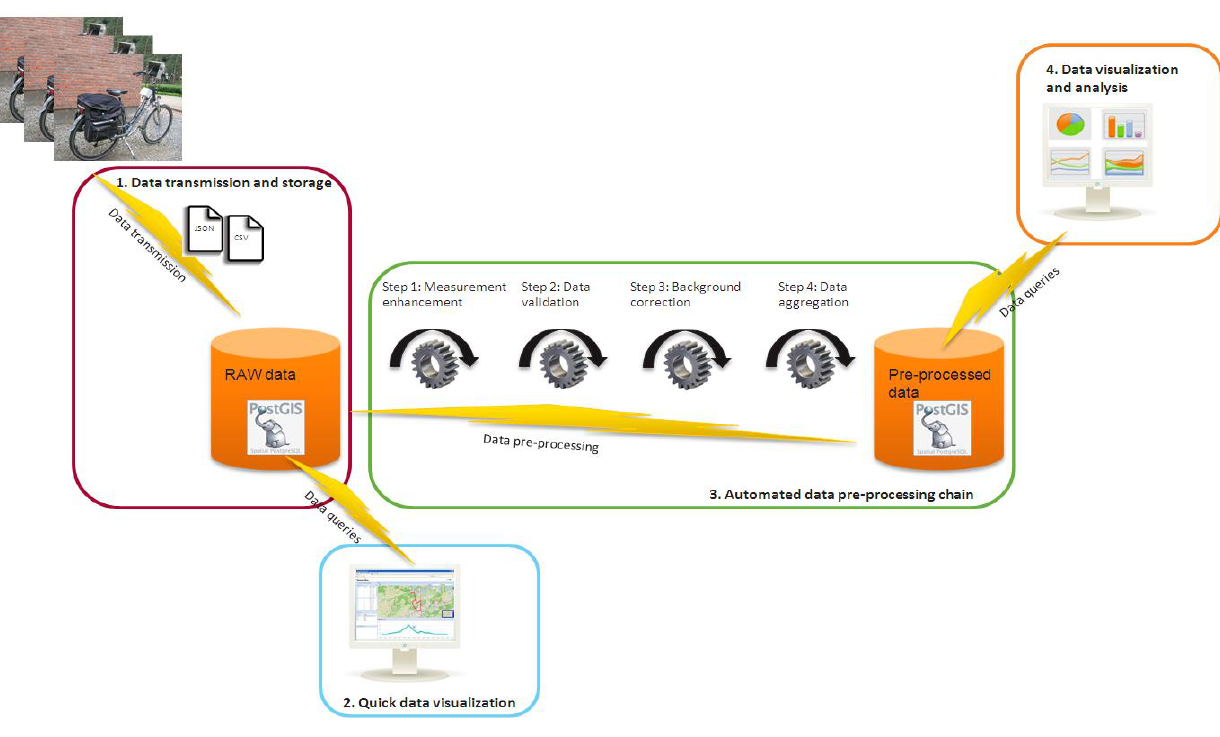
Figure 4. The Aeroflex data